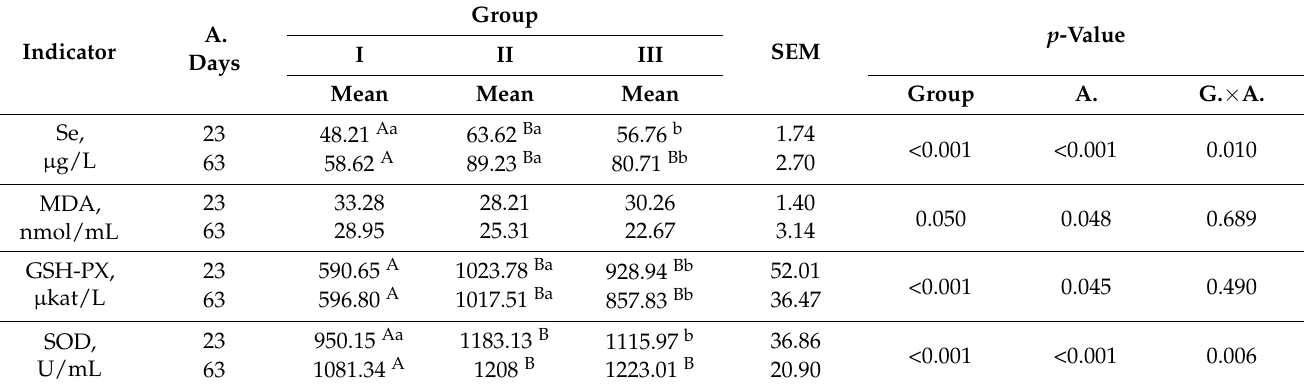
Table 3. Indicators of antioxidant status in whole blood of lambs at different